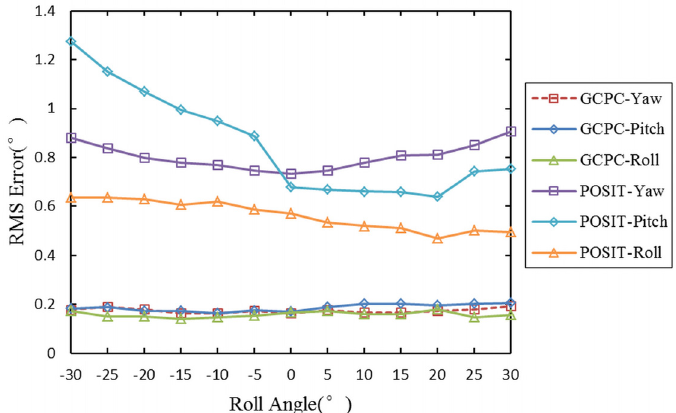
Fig 13. The RMS error of the surfaces of angle. The x axis represents the third